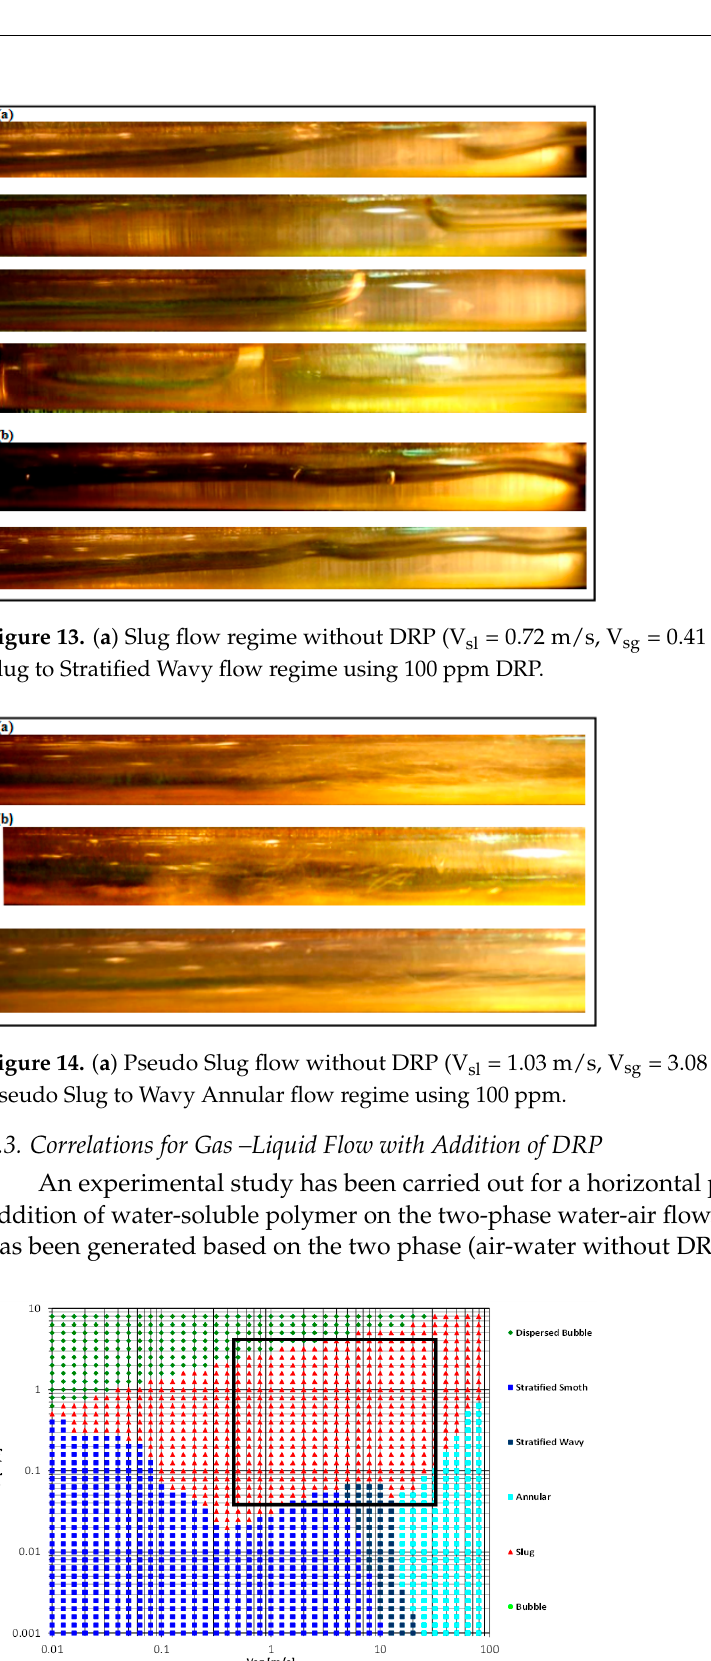
Figure 12. Effect of drag reducing polymer on pseudo slug flow regime using a concentration of 40 and 100 ppm.